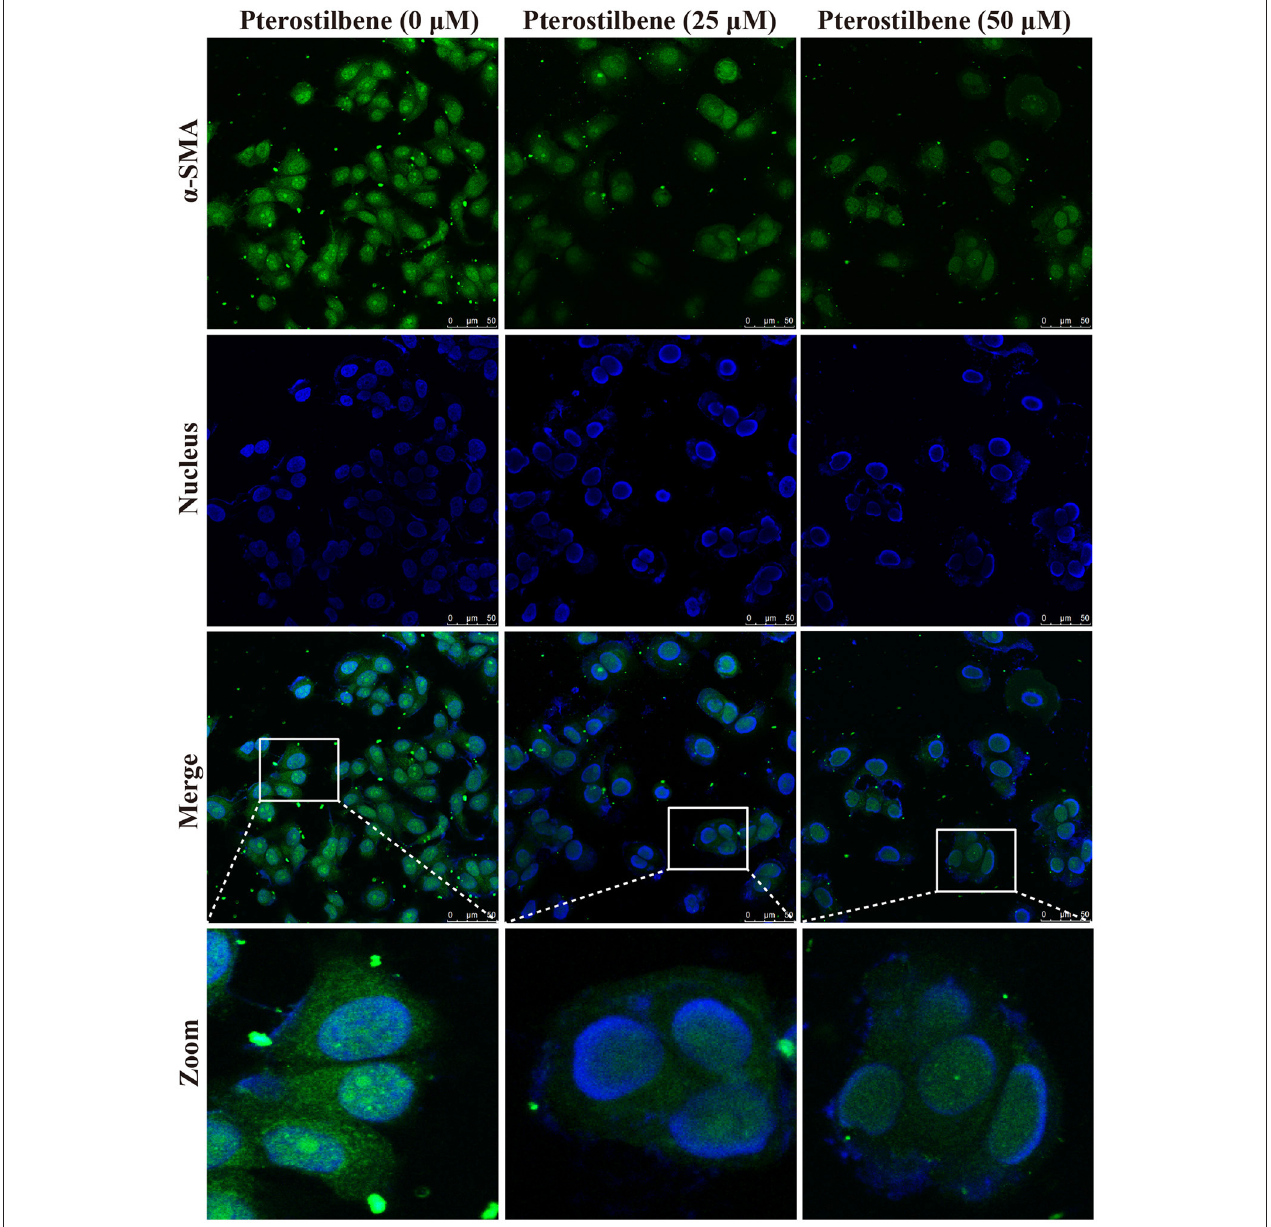
FIGURE 9 | Pterostilbene inhibited α -SMA expression as revealed by immunofluorescent staining. Cells were treated with pterostilbene at different concentrations for 24h, images captured using confocal fluorescence microscopy.